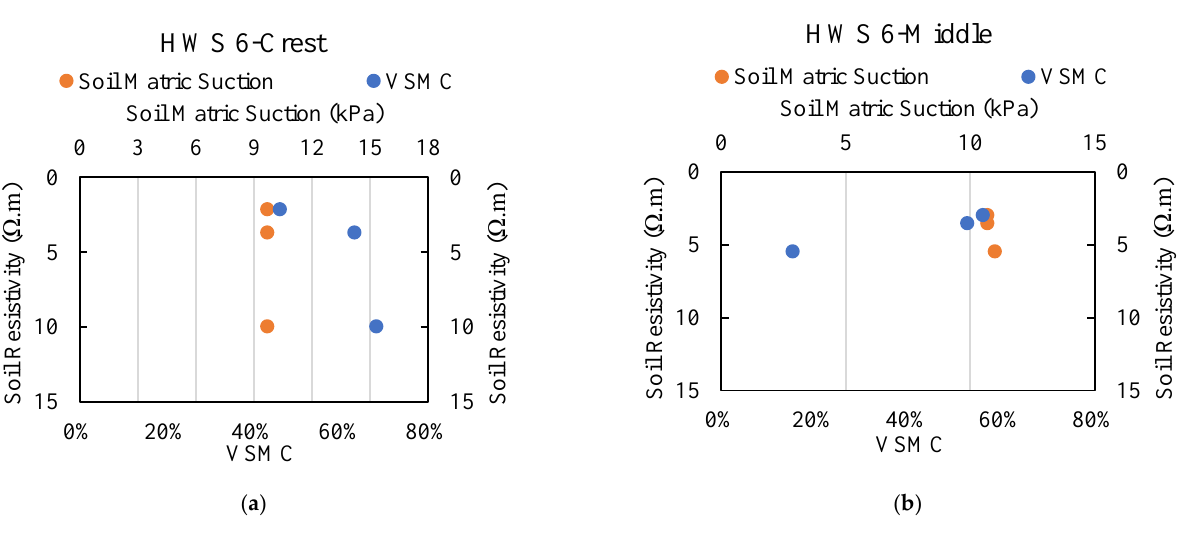
Figure 30. HWS 6, 2D ERI test profile at line A and at line B tested on 15 January 2021 (1 ft = 0.3 m).